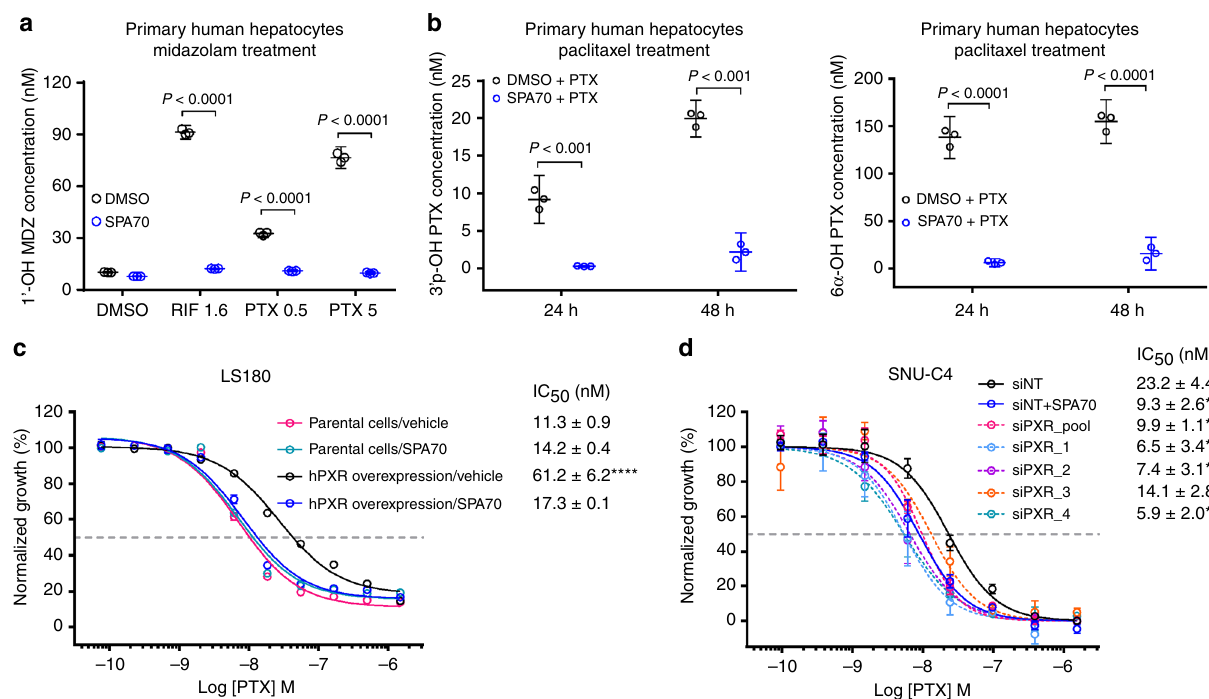
Fig. 3 SPA70 reduces the metabolism and enhances the ef fi cacy of chemotherapeutic agents. a , b SPA70 reduces the metabolism of paclitaxel (PTX) in primary human hepatocytes (PHHs). In a , PHHs were pretreated for 72 h with 0.1% DMSO, 1.6 µ M RIF or 0.5 µ M or 5 µ M PTX in the presence or absence of 10 µ M SPA70 before receiving 3.3 µ M midazolam (MDZ) and being incubated for a further 4 h. The concentrations of 1 ′ -OH MDZ (an MDZ metabolite) in the medium for each treatment were determined using LC/MS/MS. In b , PHHs were treated with 1 µ M PTX in the presence or absence of 10 µ M SPA70. The concentrations of PTX metabolites, 3-p-OH PTX (generated by CYP3A4) and 6 α -OH PTX (generated by CYP2C8), were determined using LC/MS/ MS. Each data point represents the compound concentration measured after 24 or 48 h of treatment. Data are expressed as the mean and 95% con fi dence interval (CI). c , d hPXR levels inversely correlate with the sensitivity of cancer cells to PTX. In c , LS180 cells with (hPXR overexpression) or without (parental cells) stable exogenous expression of hPXR were treated with PTX in the presence or absence of 10 µ M SPA70 for 96 h before a CellTiter-Glo assay was performed. The vehicle was DMSO. In d , SNU-C4 cells treated with pooled siRNAs (siPXR_pool) or individual siRNAs (siPXR_1, 2, 3 and 4) targeting hPXR, or with nontargeting controls (siNT) with or without SPA70, were treated with PTX for 96 h before a CellTiter-Glo assay was performed. The ‘ % normalized growth ’ was determined by normalizing the luminescent signal from compound-treated cells to that from DMSO-treated cells. The drug concentration is expressed using a log scale. Final DMSO concentration was 0.2% in a – d . The half-maximal inhibitory concentration (IC 50 ) is